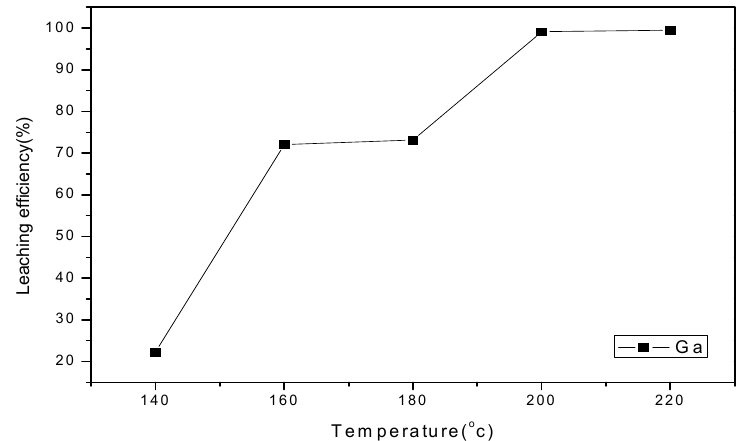
Figure 9. Effect of temperature on the leaching efficiency of gallium in 0.25 M HCl with the liquid-solid ratio 30 (mL/g), for 4 h.